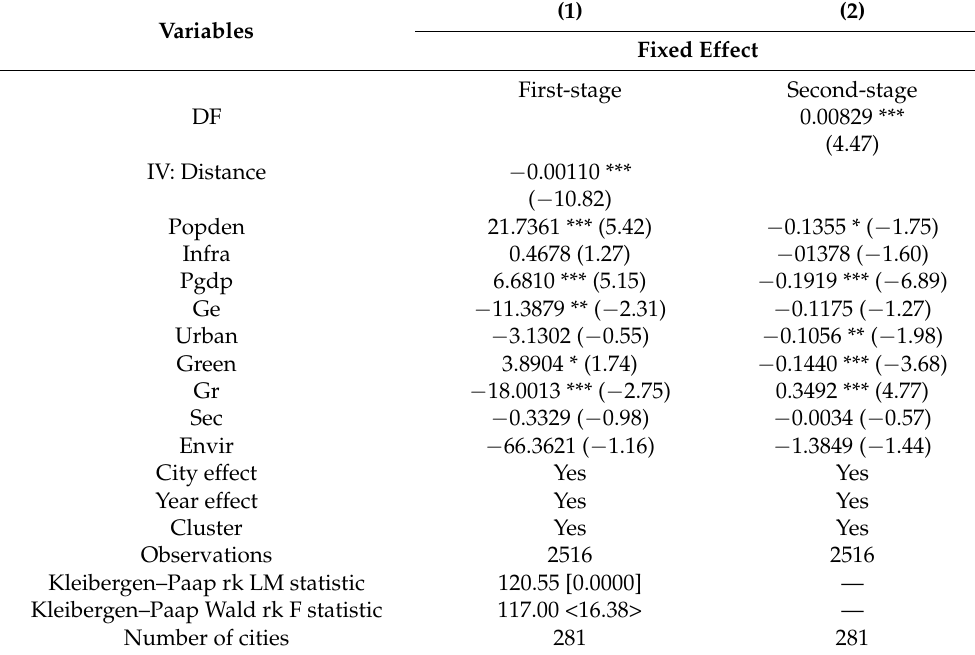
Table 7. IV-2SLS